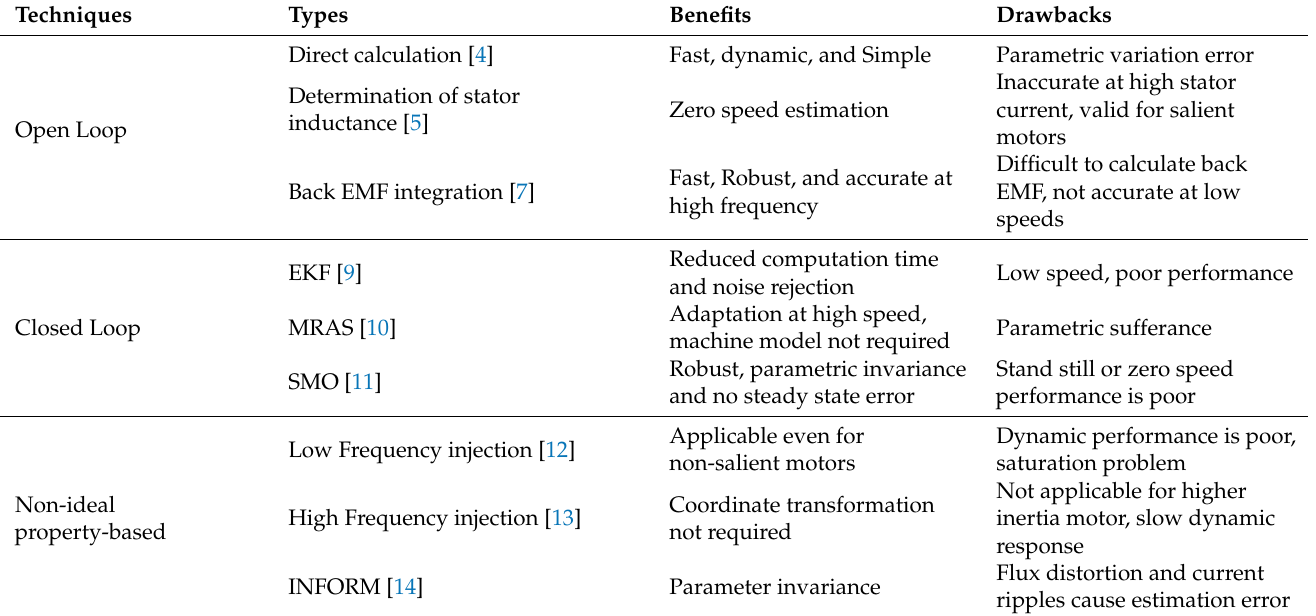
Table 1. Comparative Literature Survey on State-of-the-Art